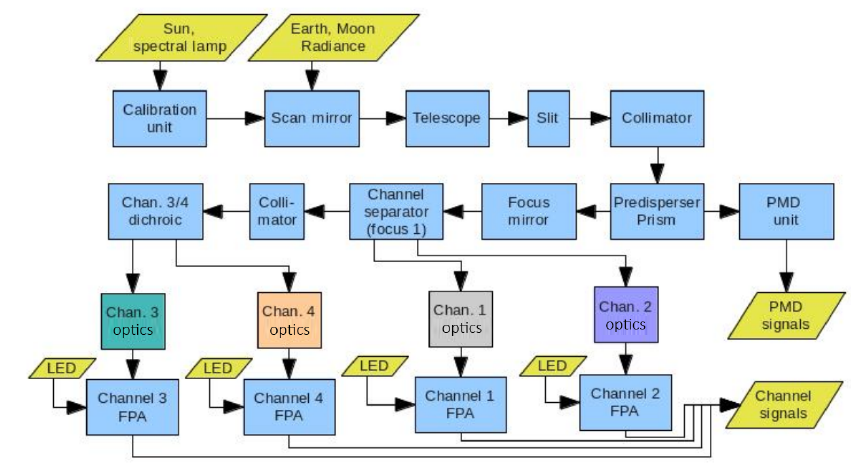
Figure 1. Functional diagram of the GOME instrument (see text for more